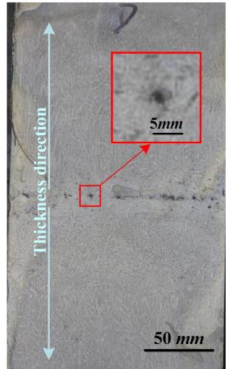
Figure 3. Macrographs of the wide-thick slab longitudinal section.